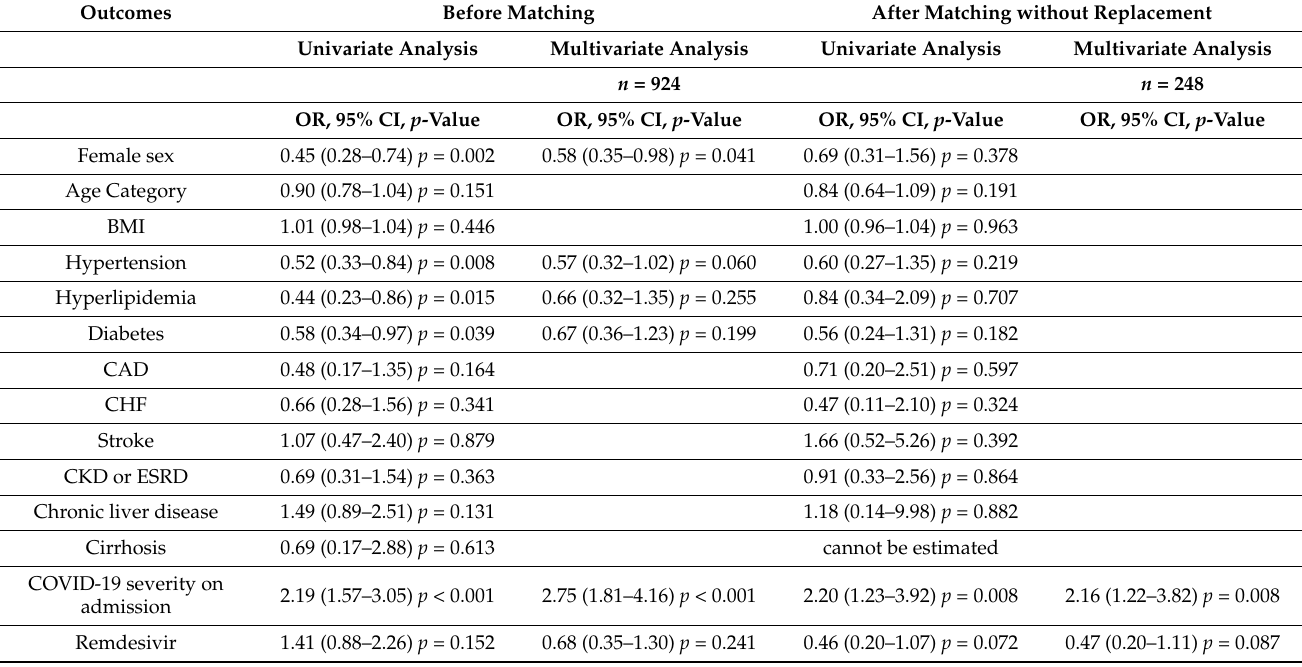
Table 6. Logistic Regression Analysis for Acute Liver Injury.